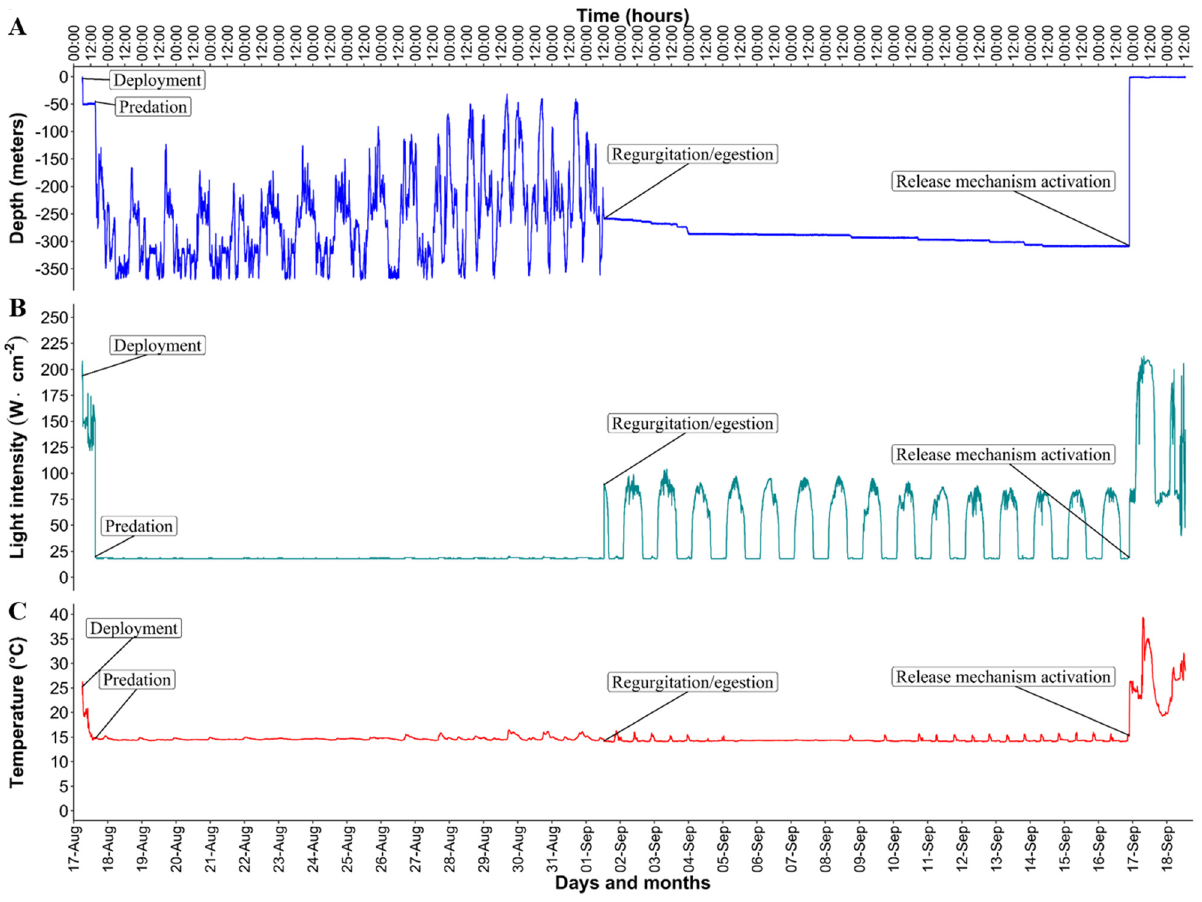
Fig. 3. Depth (a), light intensity (b) and temperature pro fi le (c) retrieved from PSAT. The time of the deployment, predation, regurgitation/ egestion and pin burn activation for each pro fi le is also